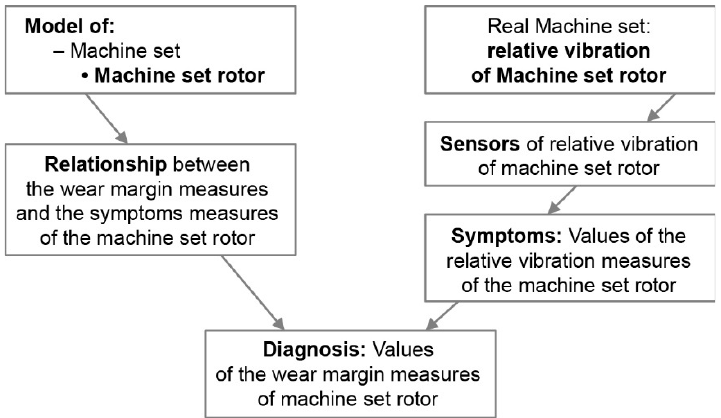
Figure 1. The algorithm of diagnosing the machine set rotor using its relative vibrations.